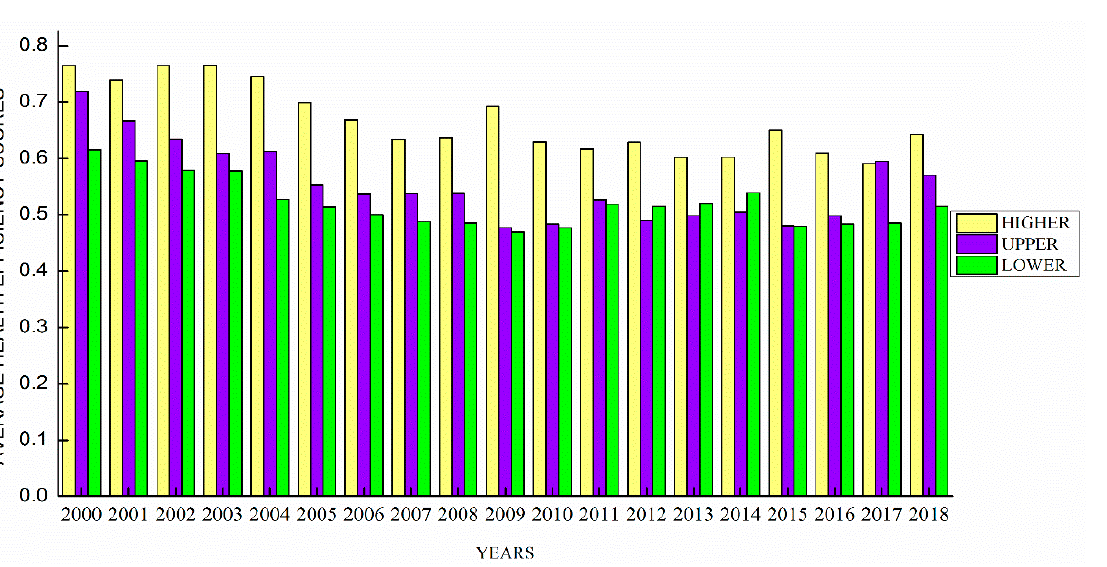
Figure 2. Average efficiency scores for health efficiency.